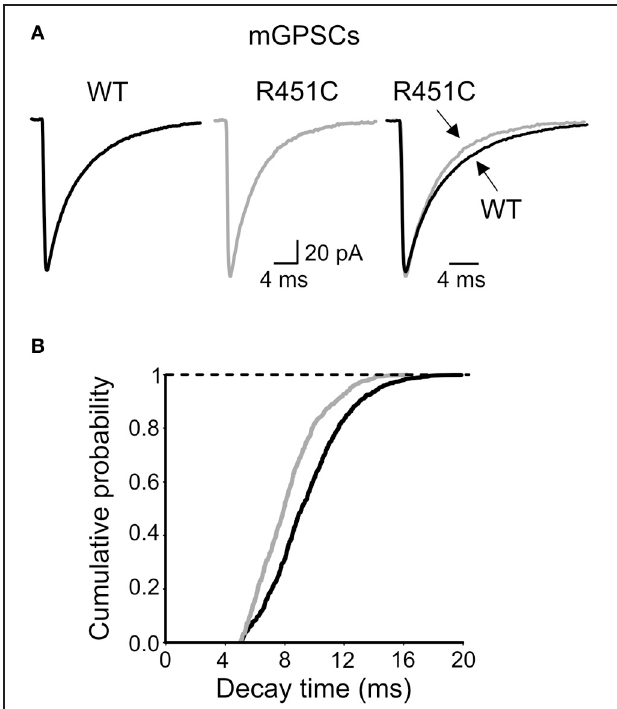
FIGURE 6 | Faster decay of mGPSCs in NL3 R451C knock-inmice. (A) Sample traces of mGPSCs (each trace is the average of > 50 individual traces) obtained from NL3 R451C knock-inmice (gray) and control littermates (WT, black). On the right the two traces are superposed. (B) Cumulative probability plot of decay times from WT (black; n = 9) and NL3 R451C knock-inmice (gray; n = 8). The two curves are significantly different ( p < 0 . 01; K–S test).